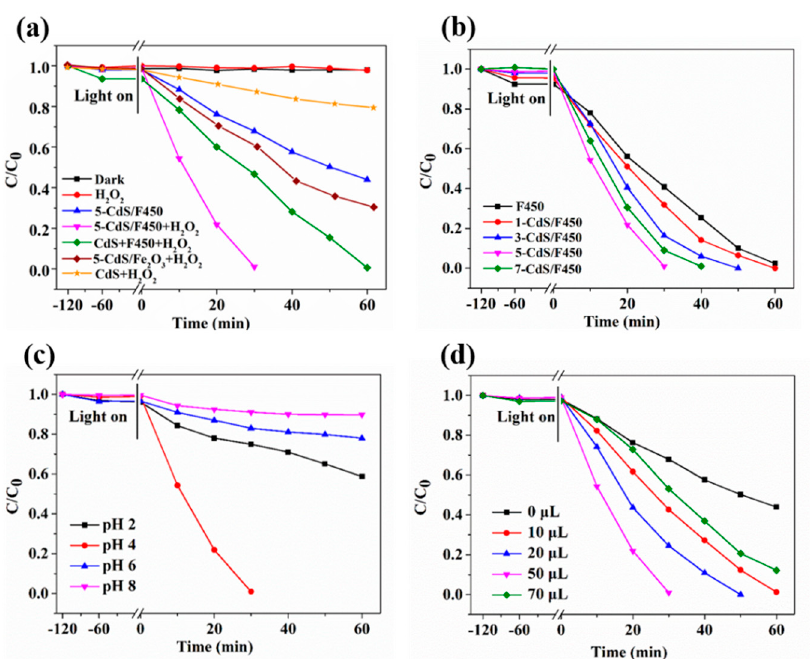
Figure 7. ( a ) Photodegradation of bisphenol A under different conditions; ( b ) photodegradation of bisphenol A over F450 and X–CdS/F450 samples; ( c ) effect of different pH values on degradation of bisphenol A; ( d ) effects of H 2 O 2 dosage on degradation of bisphenol A.